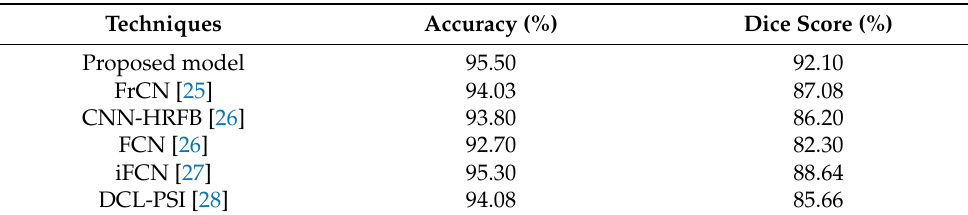
Table 2. Segmentation performance comparison between our model and existing models.